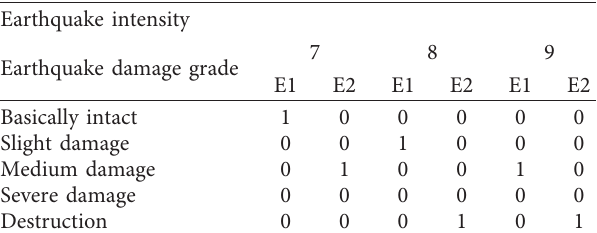
Table 12: Seismic damage prediction matrix of the bridge (according to Table 7).